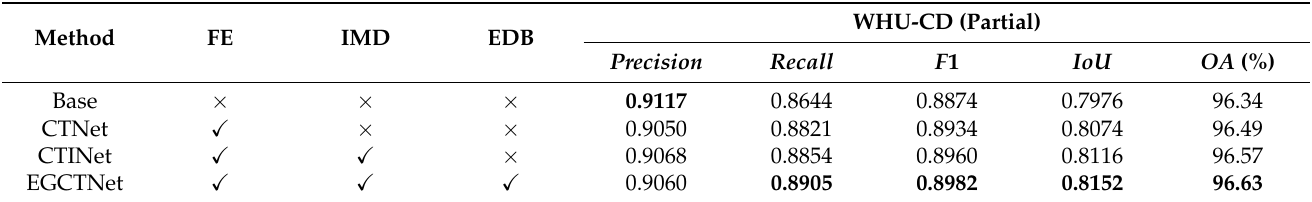
Figure 10. Comparative experimental results on the WHU-CD dataset. ( a ) Pretemporal images. ( b ) Posttemporal images. ( c ) Ground truth images. ( d ) Results of NestUnet. ( e ) Results of DTCDSCN. ( f ) Results of BIT. ( g ) Results of ChangeFormer. ( h ) Results of EGCTNet. Table 3. Accuracy comparison of ablation experiments. (The best performance is emphasized in